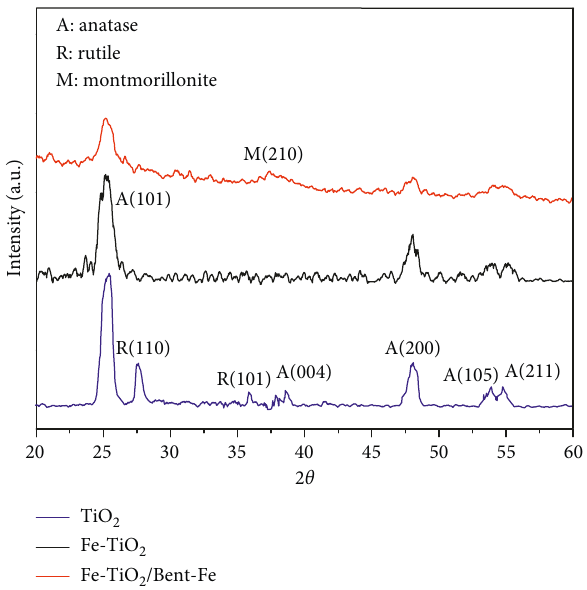
Figure 2: XRD patterns of the synthesized TiO TiO 2 /Bent-Fe